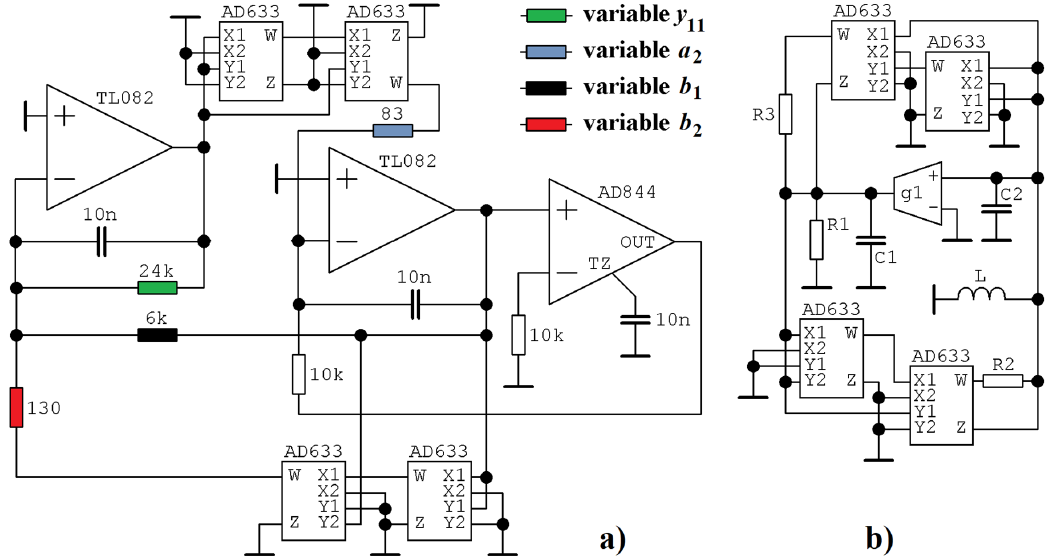
Figure 6. Two flow-equivalent practical realizations of chaotic oscillators based on a class C amplifier: ( a ) using the integrator block schematic and ( b ) directly following Kirchhoff’s first law.